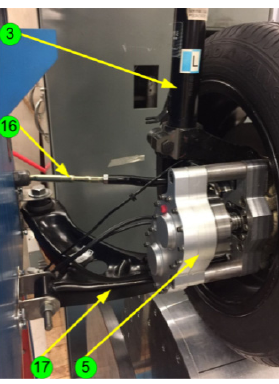
Figure 4. Partial view of developed single-wheel all-electric ABS test bench.